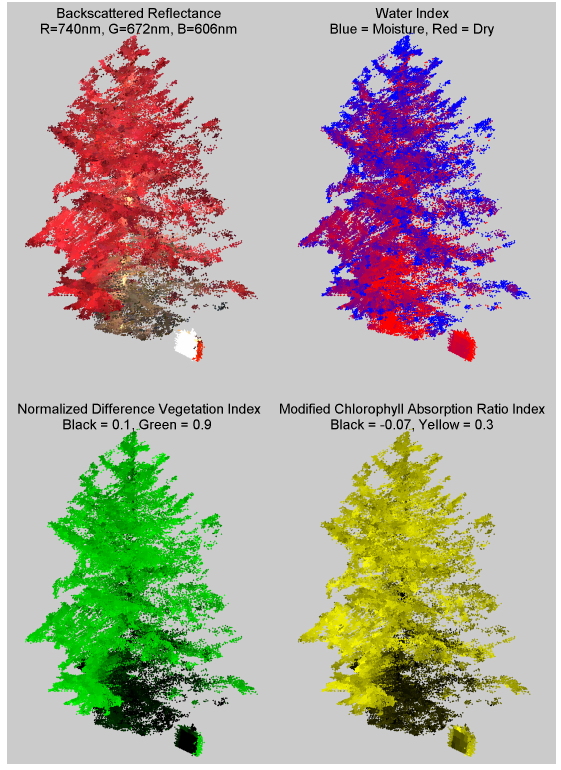
Fig. 5. Different spectral indices are calculated for 5 cm voxels and the full point cloud is colored according to the